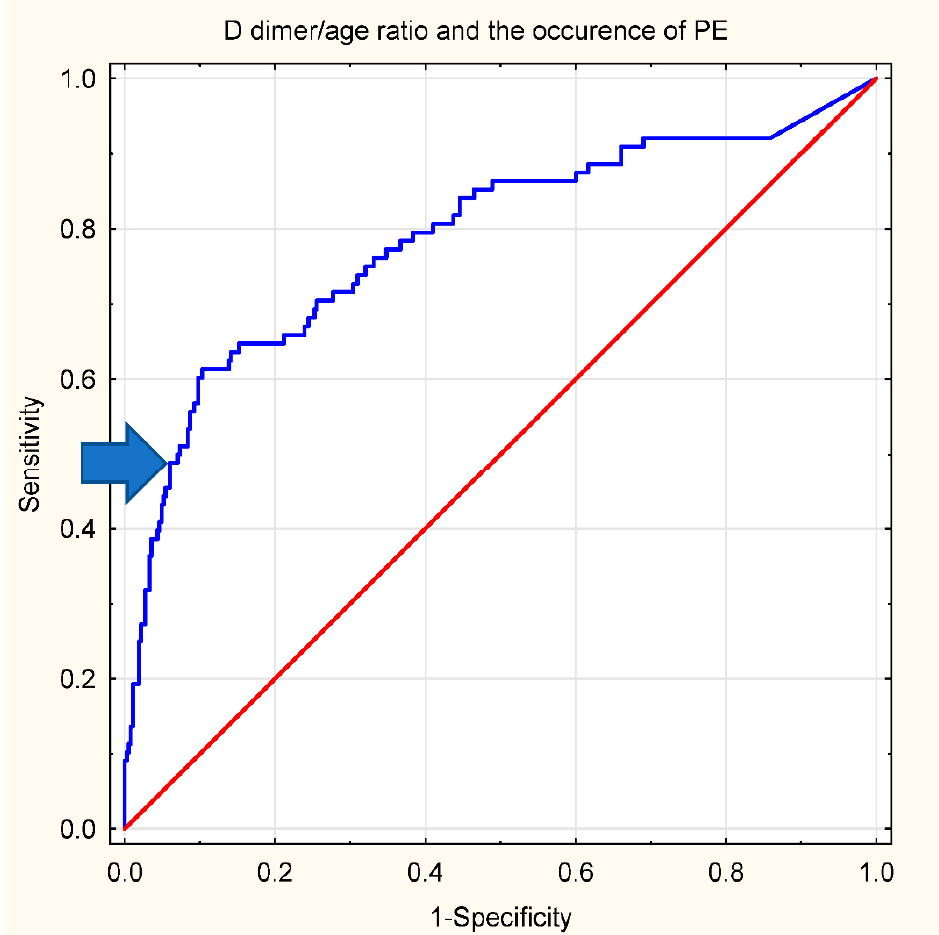
Figure 2. ROC curve for D-dimer/age ratio and occurrence of PE. AUC 0.788 (95% CI 0.727–0.848). The proposed cut-off is marked with an arrow (D-dimer/age = 70). Pts—patients. The red line is the no-effect line.